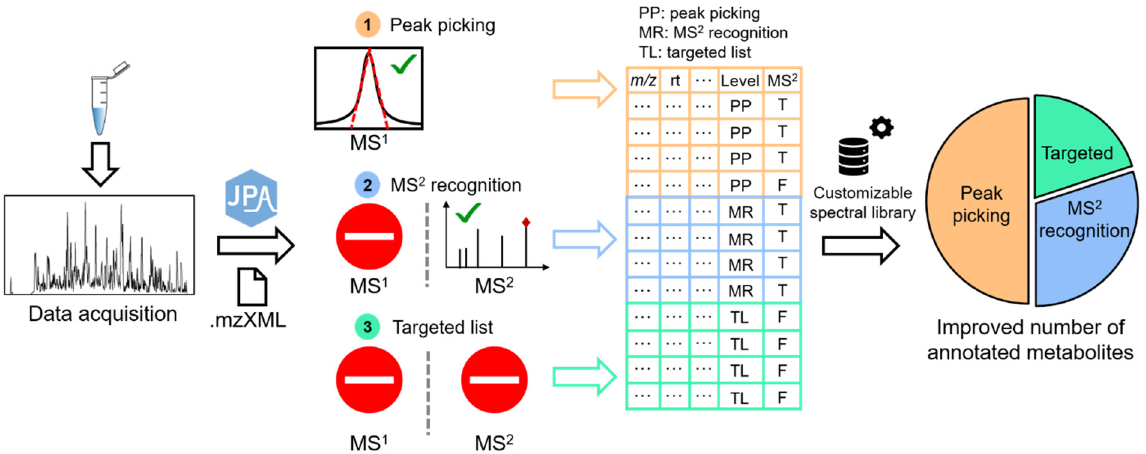
Figure 1. Schematic workflow of JPA (The numbers stand for three methods used in JPA. The green check means the feature can be detected by using either MS 1 or MS 2 . The stop sign means the feature cannot be detected by using either MS 1 or MS 2 ).